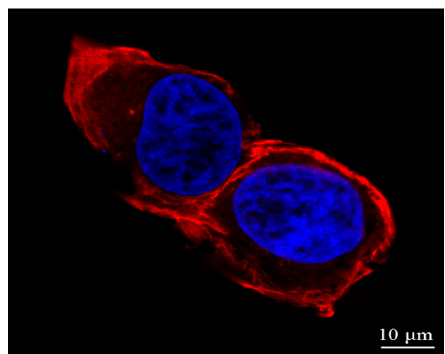
Figure 2. Atomic force microscopy (AFM) images of the osteosarcoma cell. ( a ) Topographic image of the cell at the interphase; ( b ) deflection image of the cell at the interphase; ( c ) topographic image of the cell at the telophase of mitosis; ( d ) deflection image of the cell at the telophase of mitosis; ( e ) two cross-sectional profiles of the cell shown in ( a ) and ( c ) (the positions of the cross-sections were marked by black and red lines, respectively).